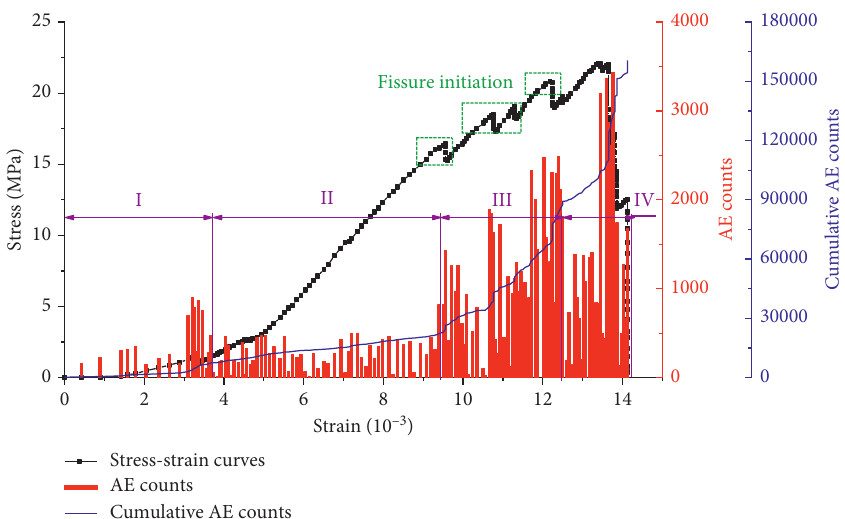
Figure 5: Stress-strain curve and acoustic emission monitoring curve of coal sample after immersion in NaCl solution.